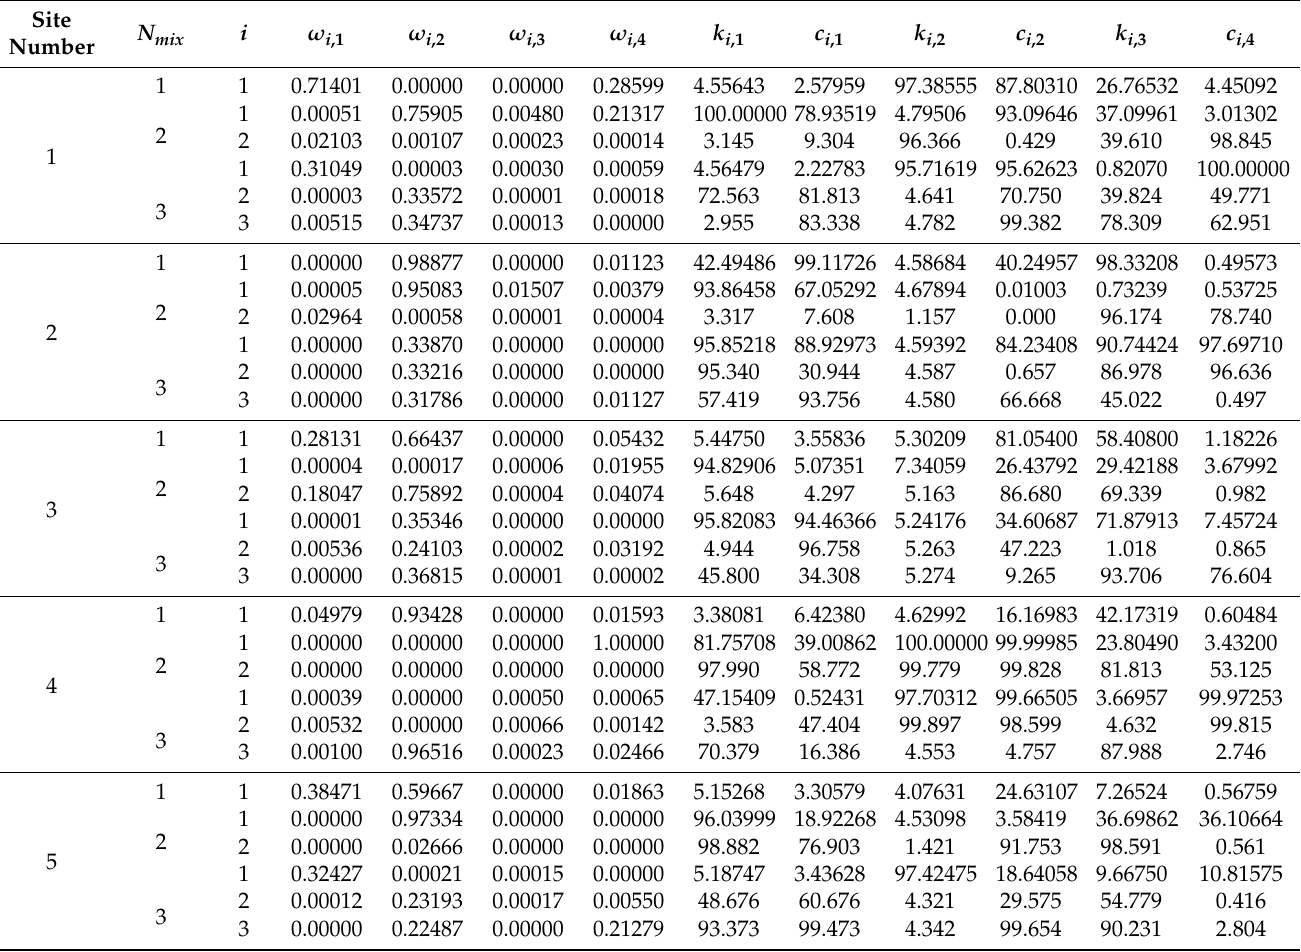
Table 9. Weights and PDFs parameters of f mix for variable wind speed spacings using the MOPSO